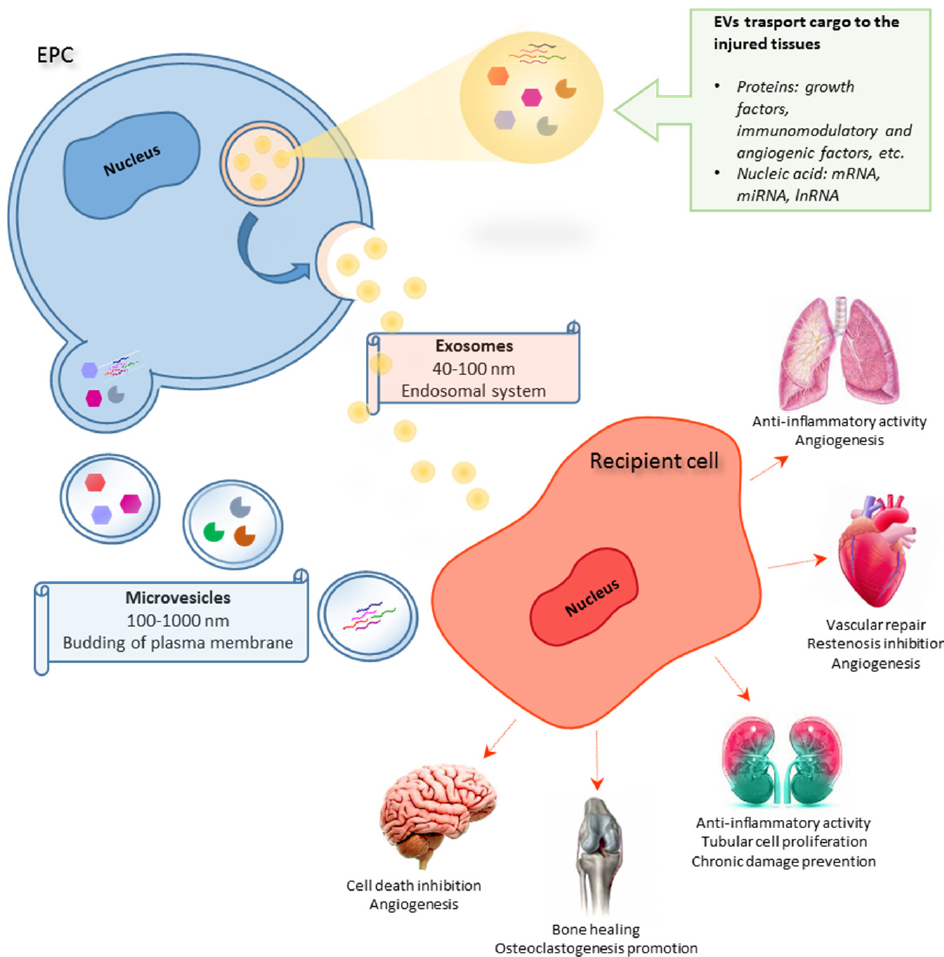
Figure 1. Schematic representation of EPC -derived EV activities on different target organs.